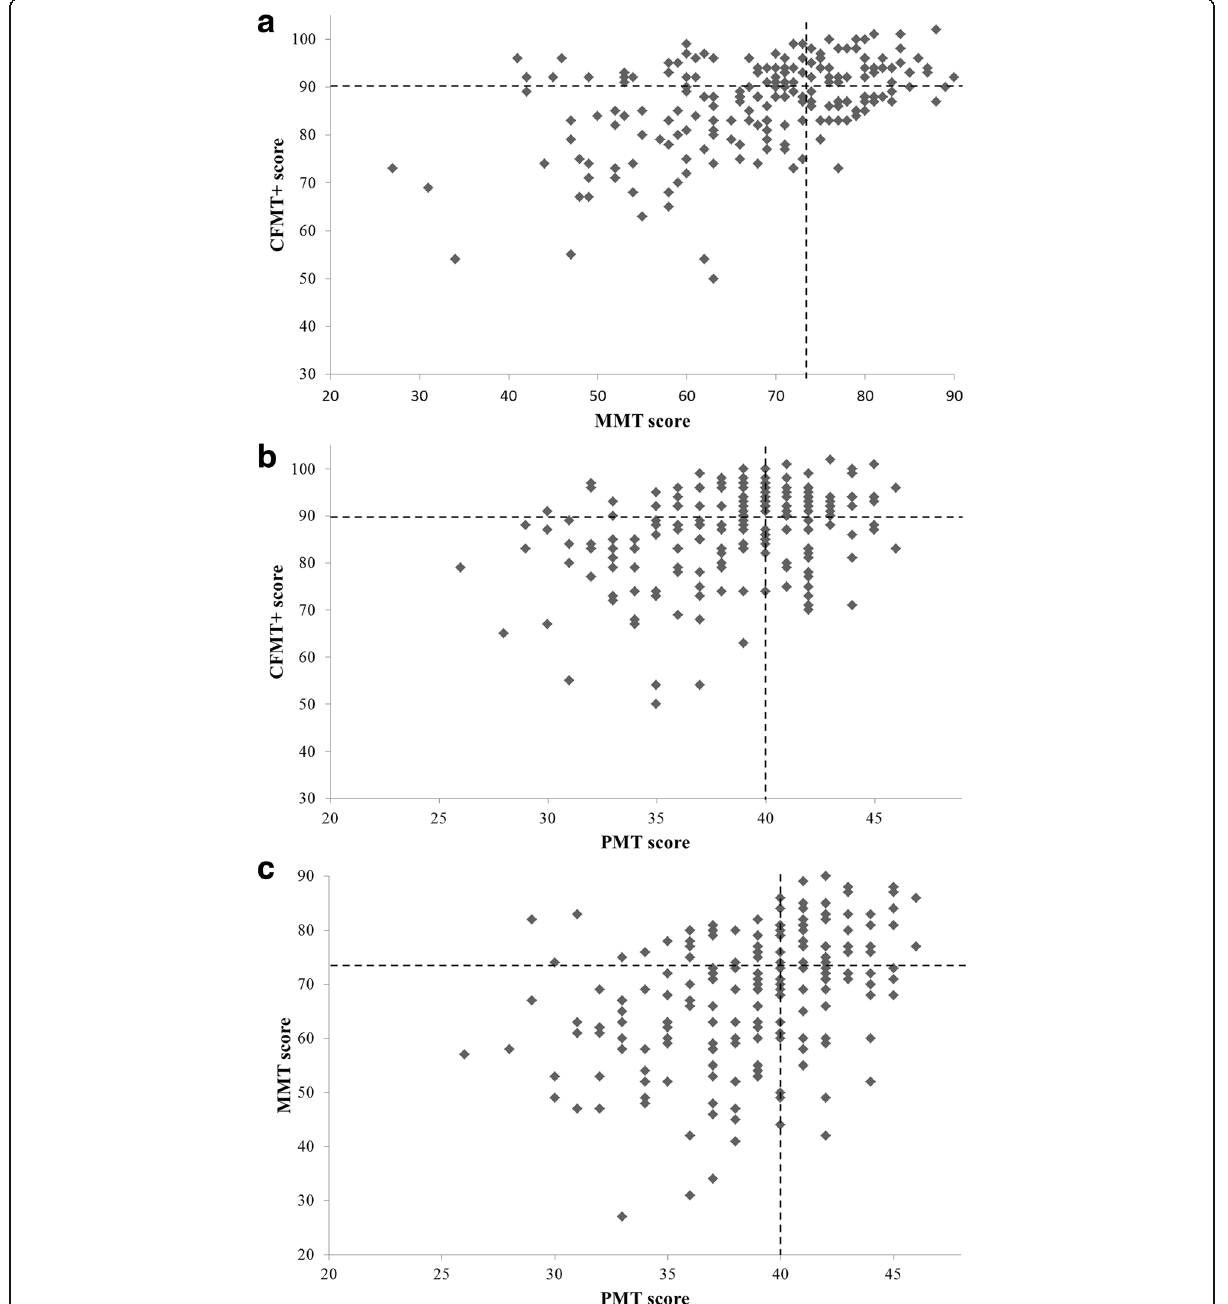
Fig. 8 Correlations in performance. Correlation between the experimental group ’ s performance on the ( a ) CFMT+ and MMT, ( b ) CFMT+ and PMT, and ( c ) MMT and PMT. Dashed lines represent cut-off values for superior performance on each test. CFMT+ long form of the Cambridge Face Memory Test, MMT models memory test, PMT pairs matching